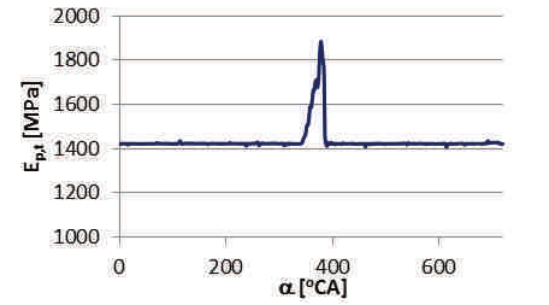
Fig. 8. The course of the modulus of elasticity of fuel was shows for one circulation of the engine The influence of inlet liquid fuel temperature and pres- sure on direct-injection diesel engines can be